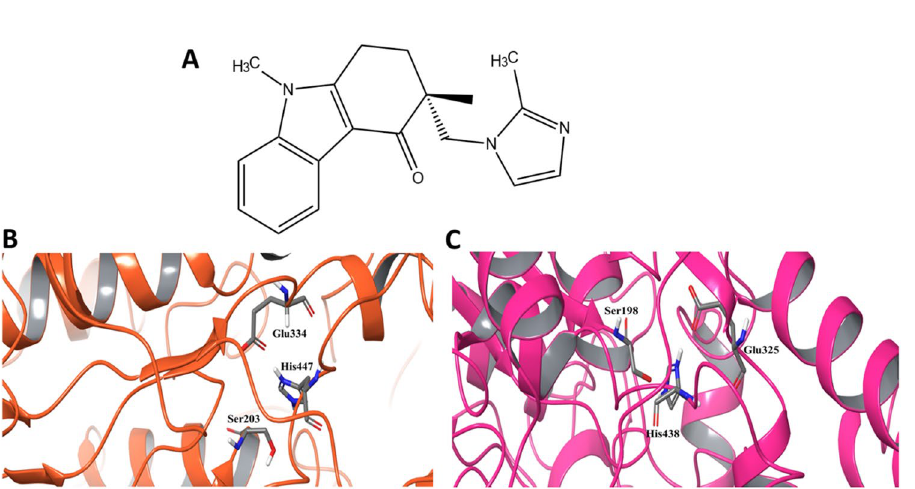
Figure 2. ( A ) Chemical structure of Ondansetron. ( B , C ) Active sites of ( B ) AChE, and ( C ) BChE, with key active site residues